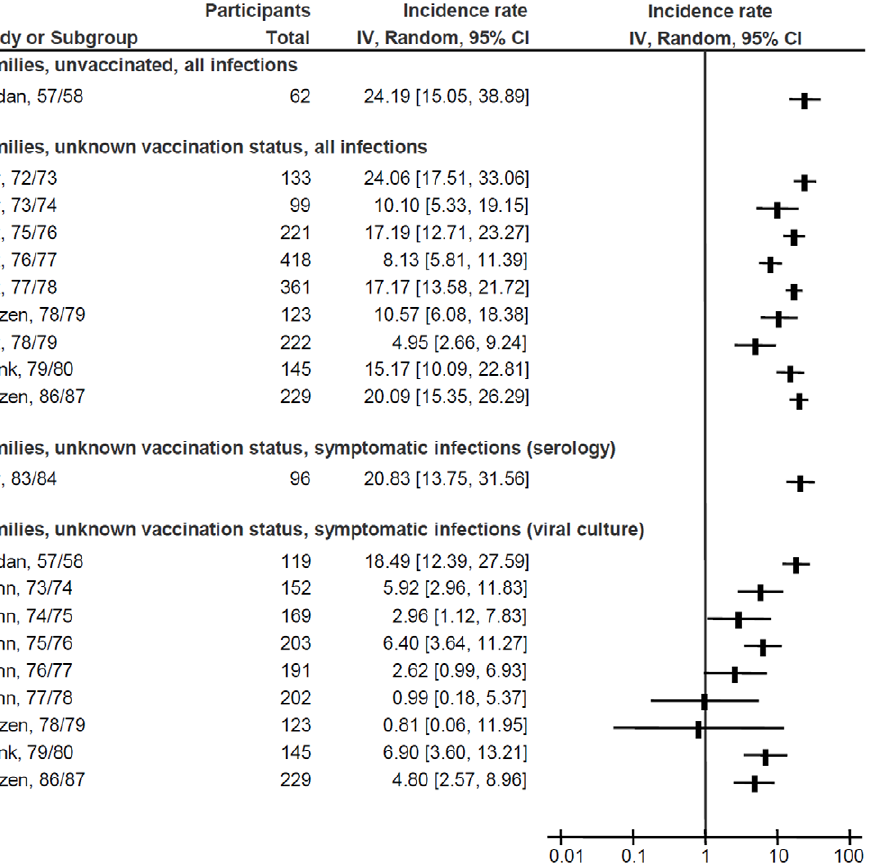
Figure 3. Forest plot of influenza incidence rates in adults sharing their households with children. Squares and horizontal lines through the squares represent incidence rates with 95% confidence intervals. Abbreviations: IV, inverse variance; CI, confidence interval; PCR, polymerase chain reaction.